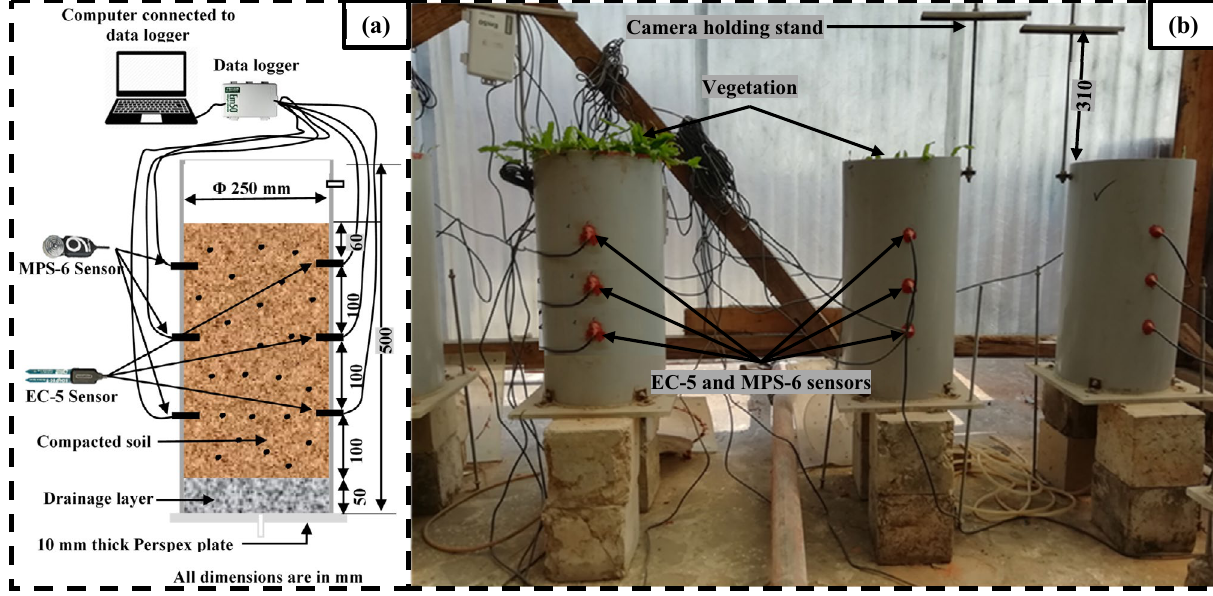
Figure 2. ( a ) schematic diagram ( b ) real image under transparent house of the experimental setup adopted for growing the Soil.